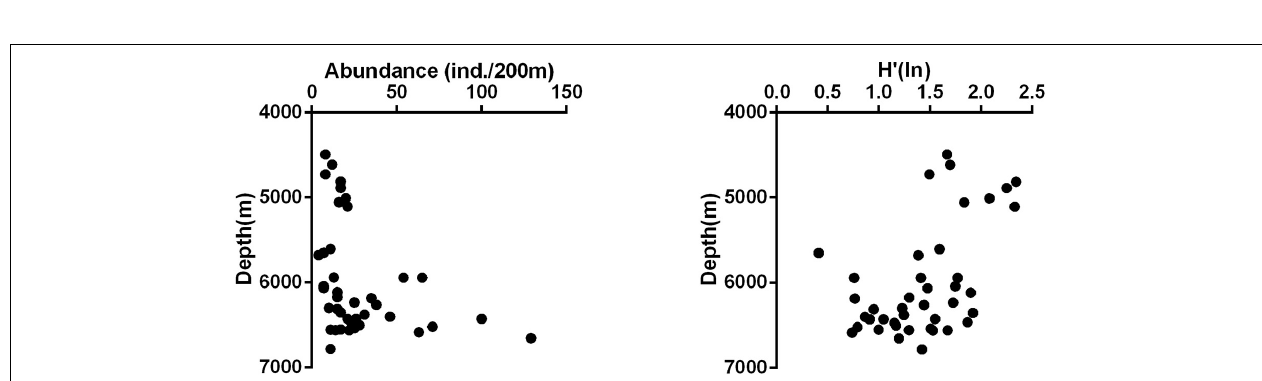
FIGURE 3 | Vertical variation of abundance and Shannon diversity of megafauna in the Yap